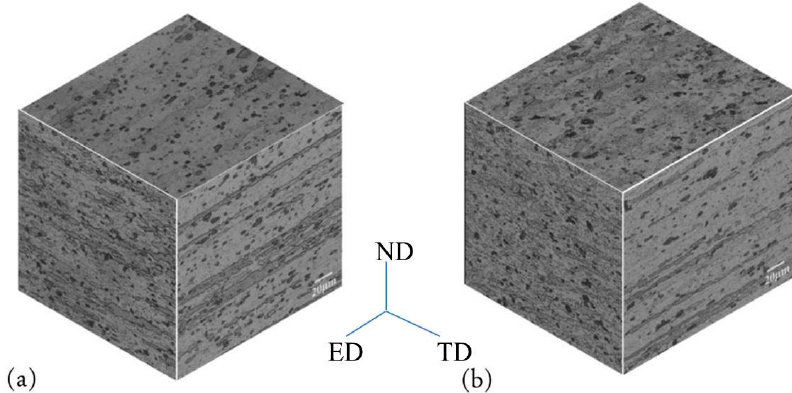
Figure 4. Microstructures of extruded alloys: ( a ) 3-mm-thickness extruded material (Ex3) and ( b ) 9-mm-thickness extruded material (Ex9). ED: extruded direction; ND: normal direction; TD: transverse direction.